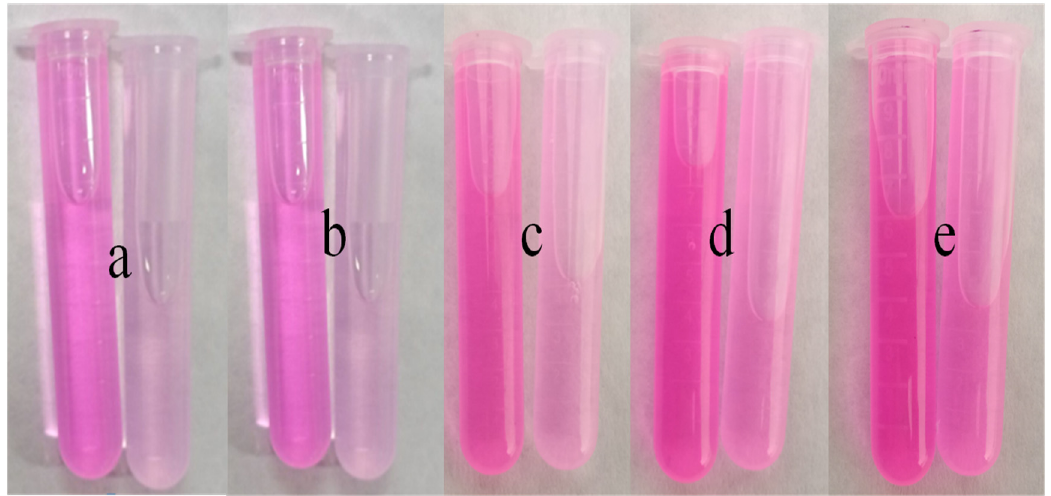
Figure 5. Color comparison of solution before and after RhB removal ( a ) 10mg/L; ( b ) 20mg/L; ( c ) 30mg/L; ( d ) 40mg/L; ( e ) 50mg/L.